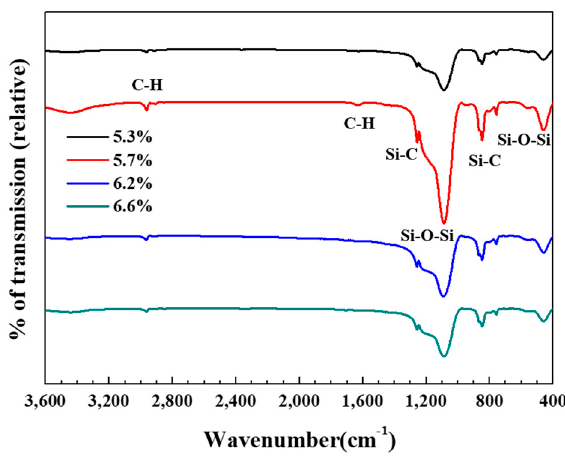
Figure 6. FT-IR spectra of silica aerogel powders prepared from water glass solutions with different concentrations.